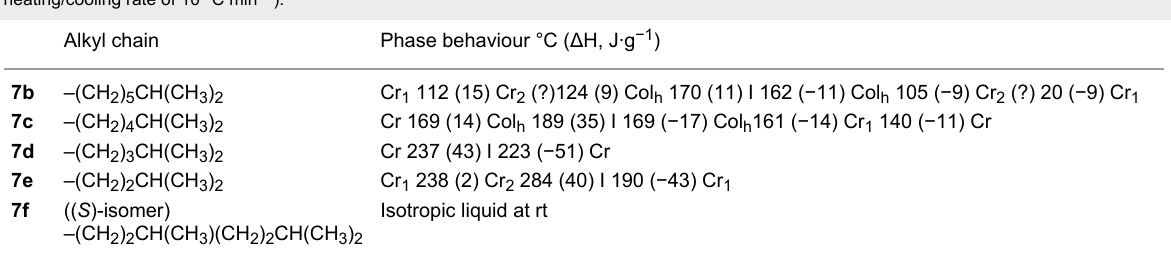
Table 2: Phase behaviour of the phthalocyanines determined by differential scanning calorimetry (second heating and first cooling cycle and a heating/cooling rate of 10 °C min − 1 ). Alkyl